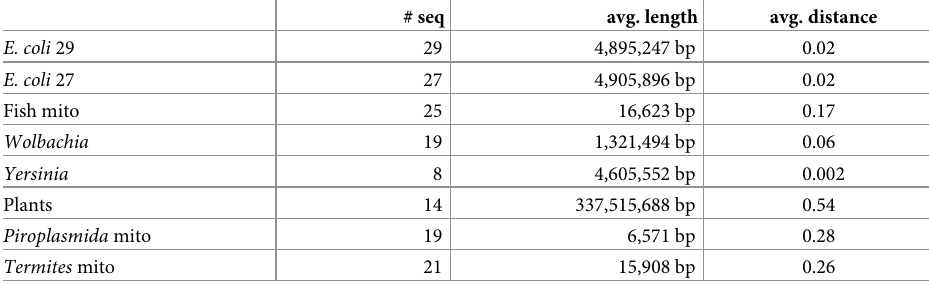
Table 1. Benchmark data sets used to evaluate our approach with number of sequences and average sequence length. The last column contains the average phylogenetic distance in the respective data set, measured as substitutions per position, estimated by the program FSWM